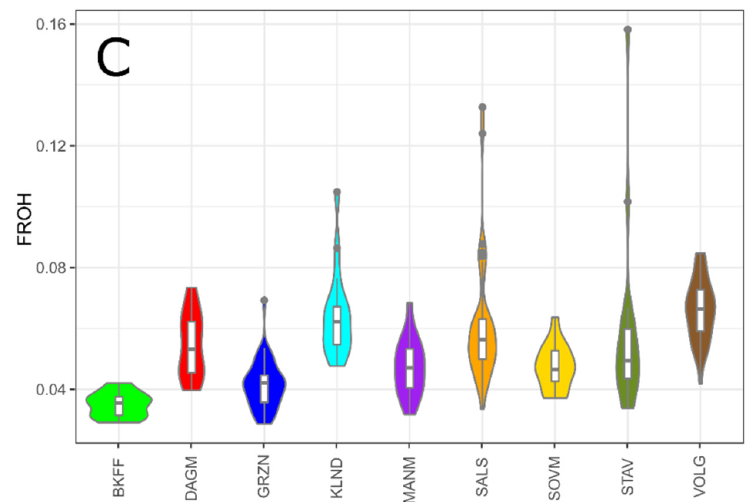
Figure 4. The genomic inbreeding coefficient based on ROH (FROH) in Russian sheep breeds: ( A ) FROH values within the group of coarse wool breeds; ( B ) FROH values within the group of semi-fine wool breeds; ( C ) FROH values within the group of fine wool breeds.